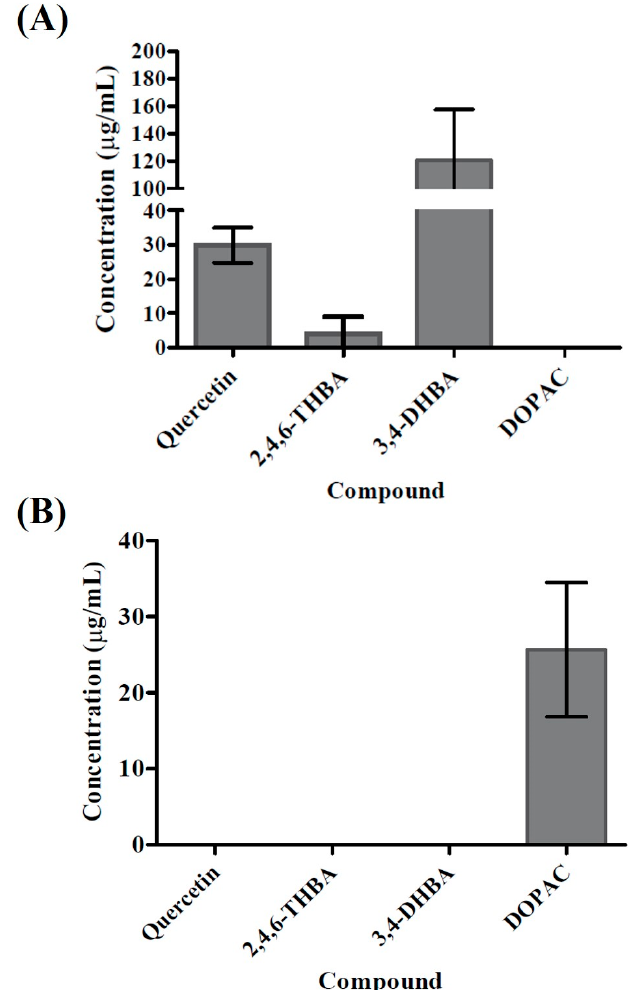
Figure 4. Detection of the metabolites generated by B. glycinifermentans ( A ) and F. plautii ( B ) following quercetin degradation. HPLC revealed that B. glycinifermentans generated 2,4,6-THBA and 3,4-DHBA ( A ) while F. plautii generated DOPAC ( B ) upon exposure to quercetin for 24 h. The concentration of each product estimated through standard curves using pure compounds is expressed in μ g/mL.